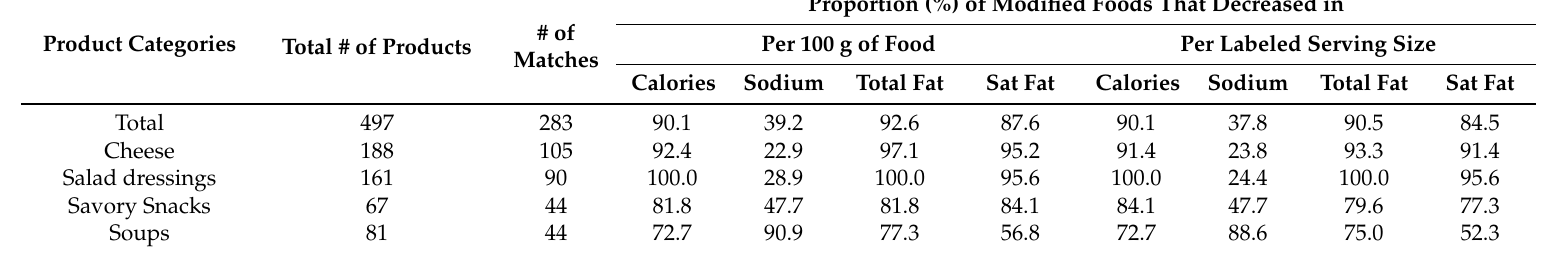
Table 1. Difference in modified foods nutrient content compared to regular foods in each of the four food categories 1 .